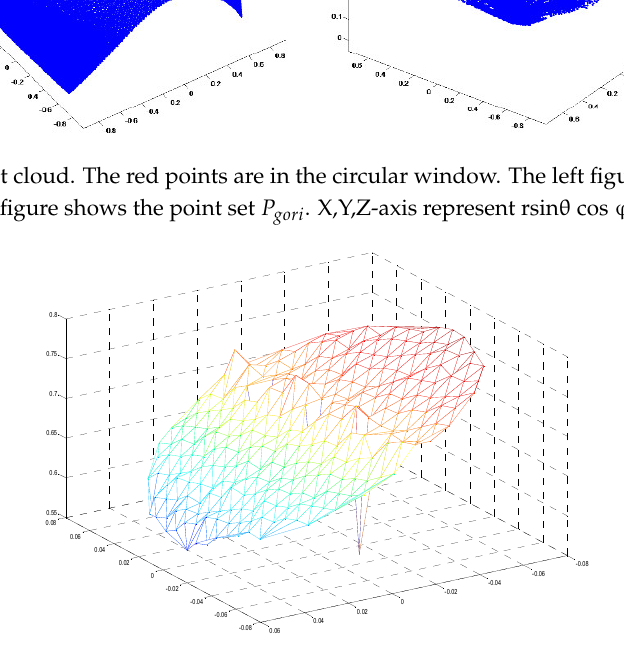
Figure 6. Result of triangulating the point set P gori . X,Y,Z-axis represent gsin θ cos ϕ , gsin θ sin ϕ , gcos θ .